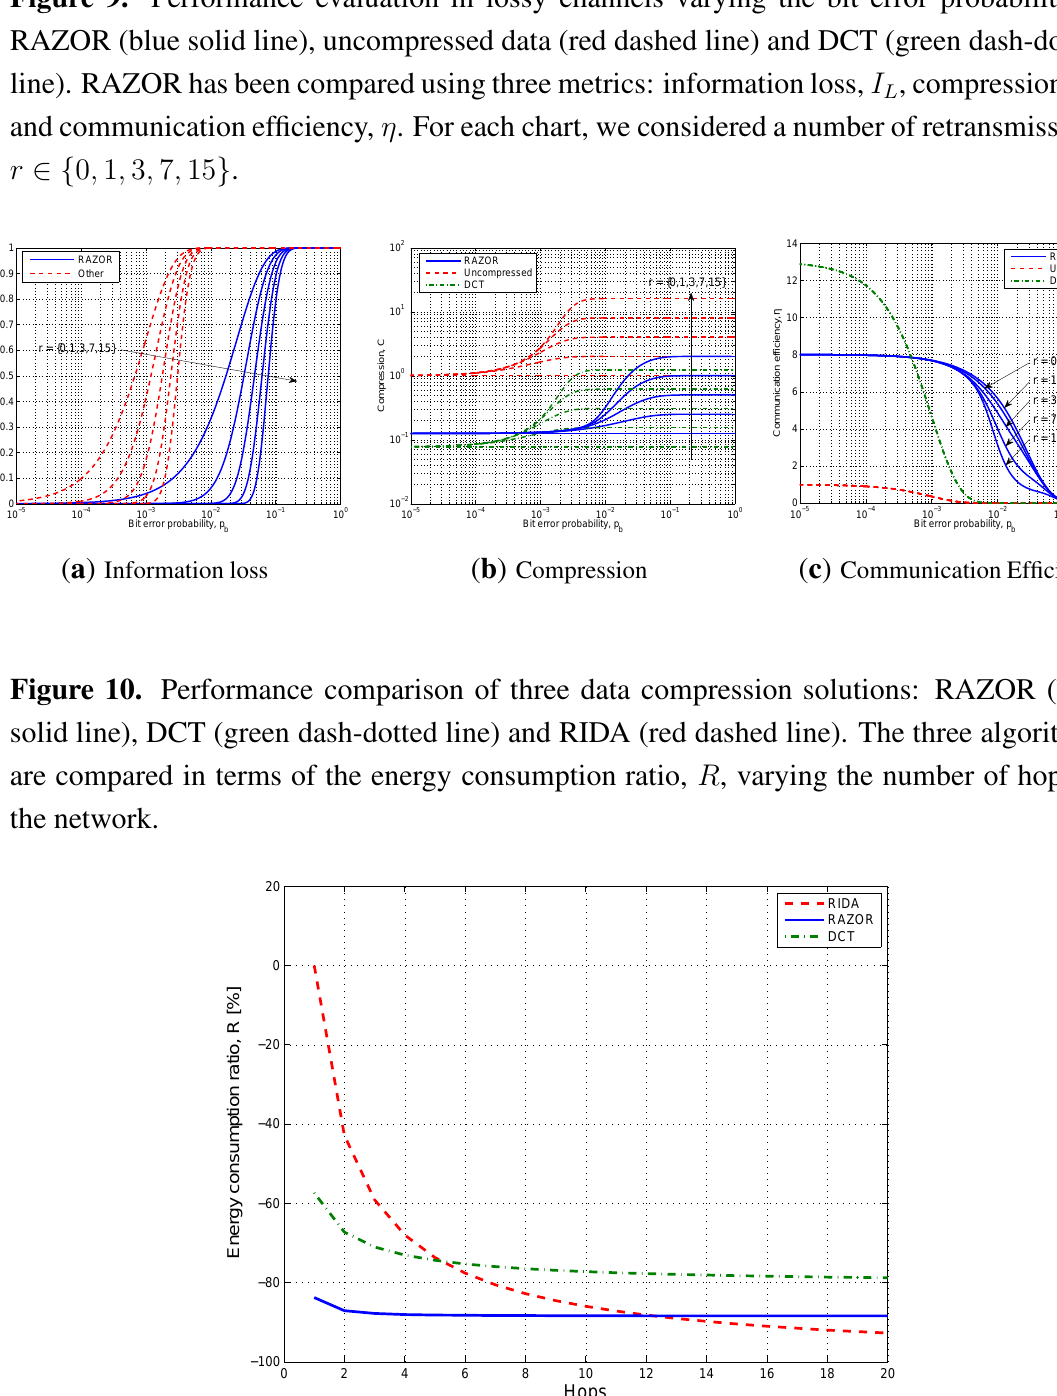
, compression, C , L